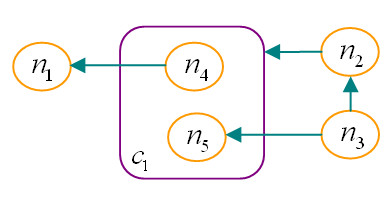
Example compound graph. An example compound graph (V (G) = {n1, n2, n3, n4, n5, c1}, E(G) = {n2c1, n3n2, n3n5, n4n1}, and I = {c1n4, c1n5}). The order, in which nodes are traversed, depends on the relationship between a compound structure and its members and on the relationship between members of a compound structure.